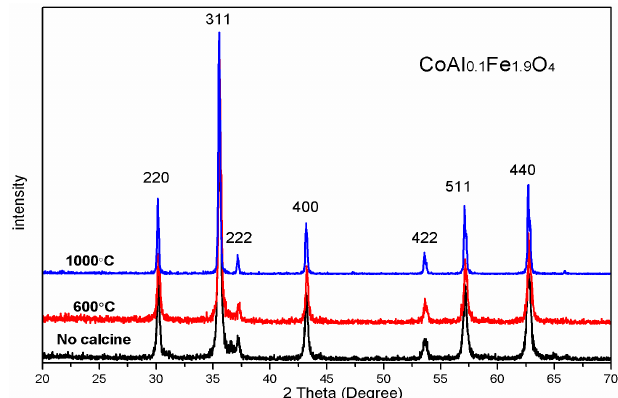
Figure 3. XRD patterns of ferrite CoAl 0.1 Fe 1.9 O 4 calcined at different temperatures. Table 2. XRD data of ferrite CoAl 0.1 Fe 1.9 O 4 calcined at different temperatures. Temperature ( ℃ )